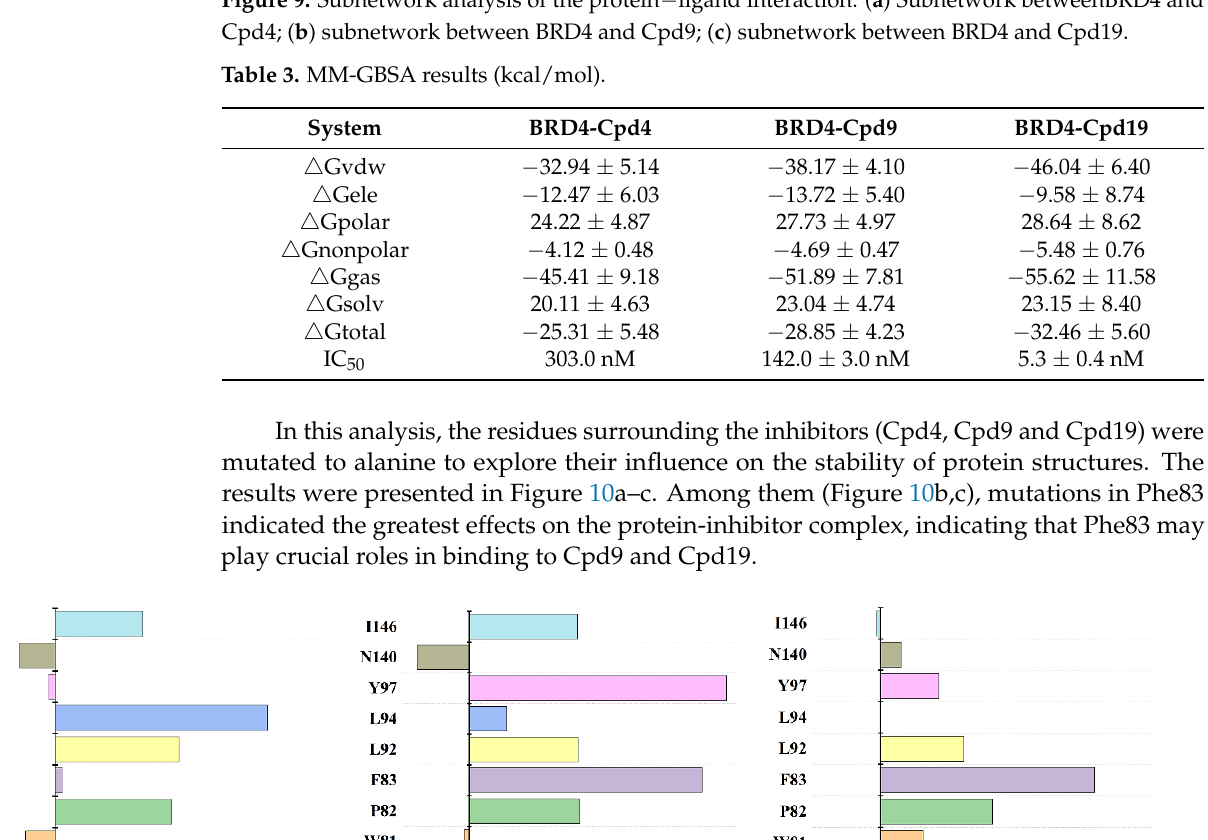
Figure 9. Subnetwork analysis of the protein−ligand interaction. ( a ) Subnetwork betweenBRD4 and Cpd4; ( b ) subnetwork between BRD4 and Cpd9; ( c ) subnetwork between BRD4 and Cpd19.